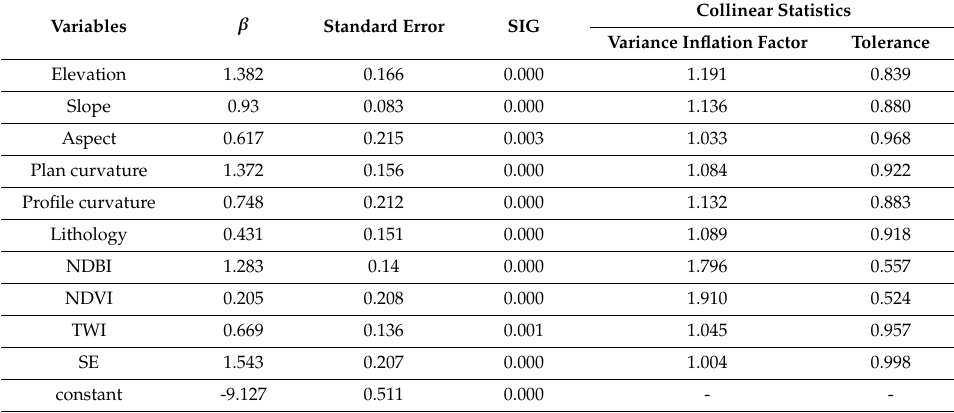
Table 3. Parametric statistics in the SE_LR model with 60 m grid resolutions.